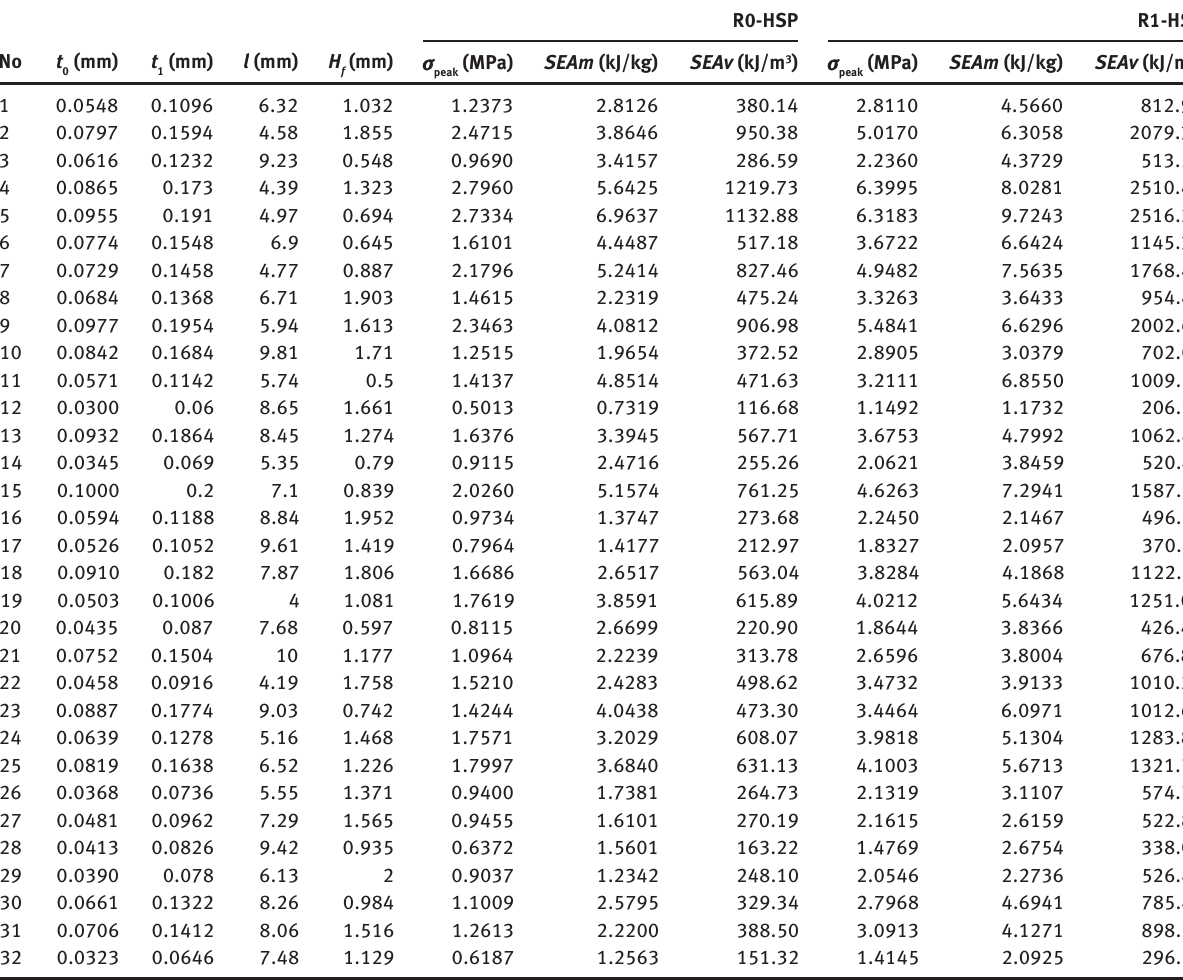
constraint (1.21 MPa).